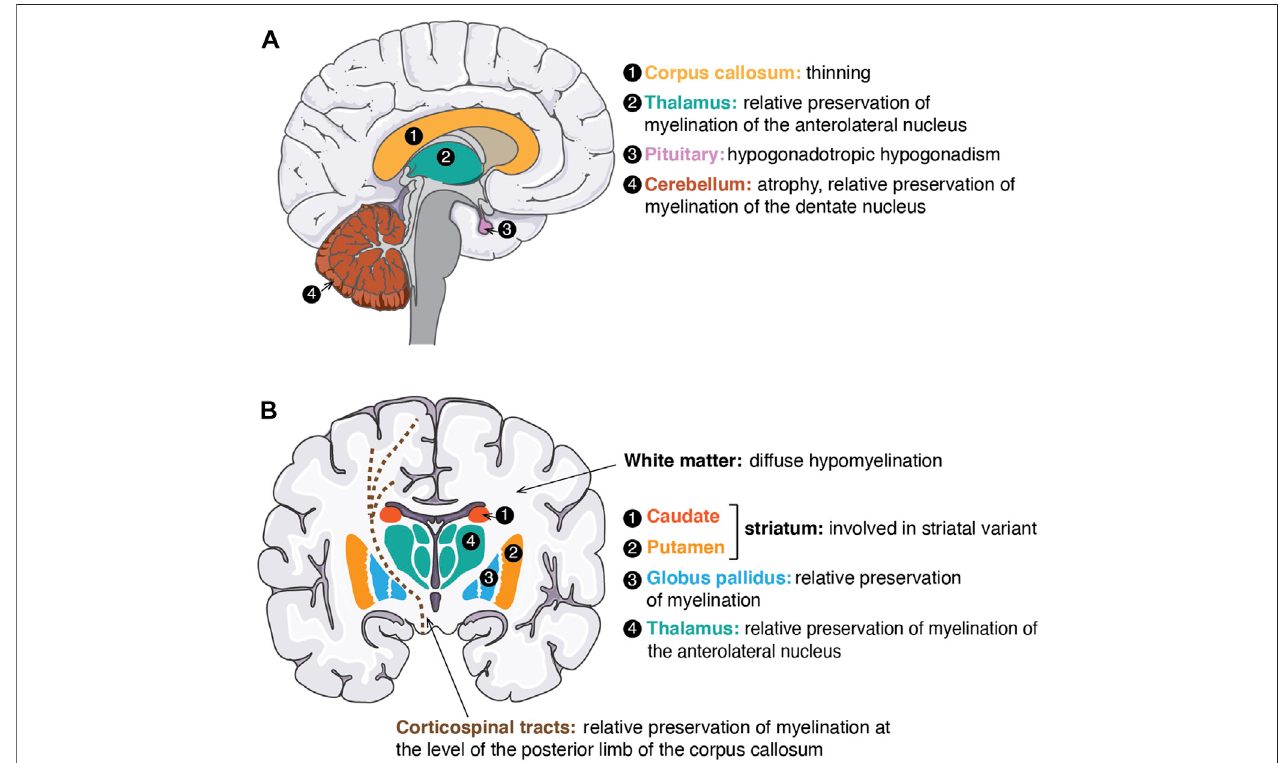
FIGURE 3 | Neuro-anatomical structures affected or for which myelination is preserved in POLR3-related disorders. (A) Schematic of a sagittal view of the human brain. Structures involved/preserved in POLR3-HLD are depicted in distinct colours and labeled with a number. On the right side, the names of anatomical structures corresponding to each number are shown in the same colour as the structure, followed by a description of how the structure is affected/preserved in POLR3-HLD. (B) Schematic of a coronal view of the human brain. Structures involved/preserved in the striatal variant of POLR3-related disorders (caudate and putamen) or in POLR3-HLD (other structures) are shown in distinct colours and labeled withanumber.The legend on theright side follows the same description asin (A) . White matter (in white on the brain schematic) is indicated by an arrow. Corticospinal tracts are displayed as brown dashed lines. The fi gure was adapted from images available on